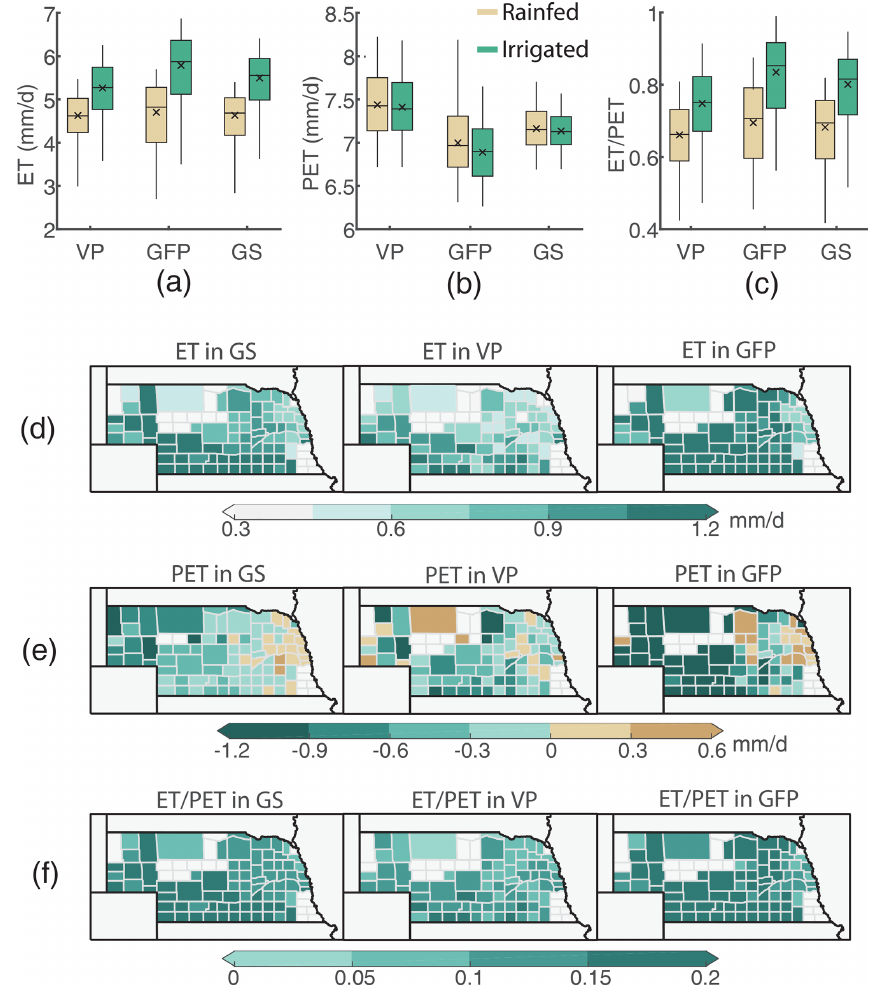
Figure 6. Box plot of SSEBop ET, MODIS PET, and ET / PET for irrigated and rainfed maize areas (a–c) . Spatial pattern of SSEBop ET, MODIS PET, and ET / PET differences between irrigated and rainfed maize areas (d–f)